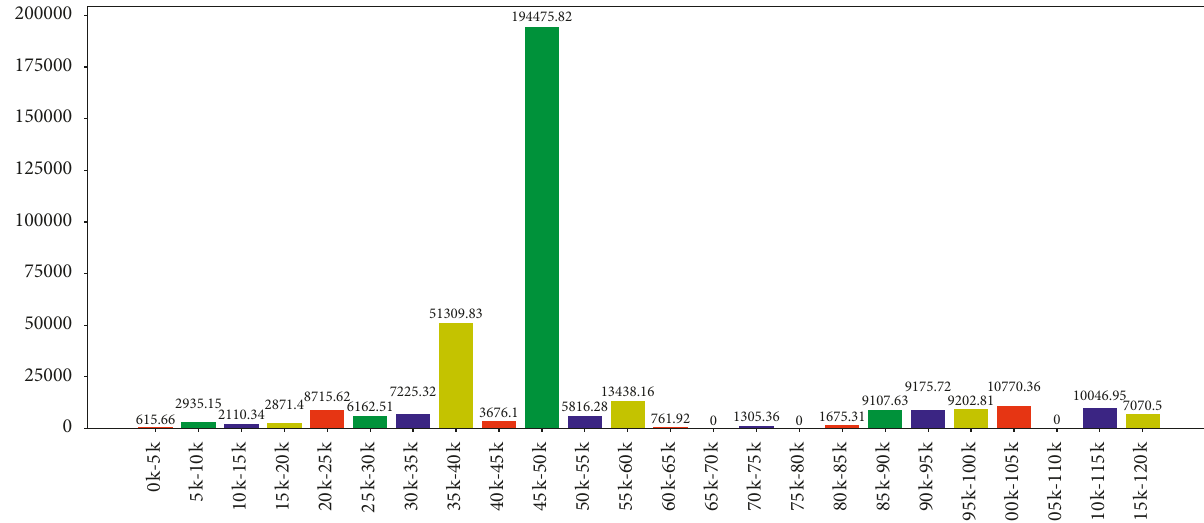
Figure 9: Statistical chart of the newly added registered capital scale of the company after the opening of railway stations in three years. The abscissa indicates the average value of the registered capital of the newly added company after the opening of the railway.